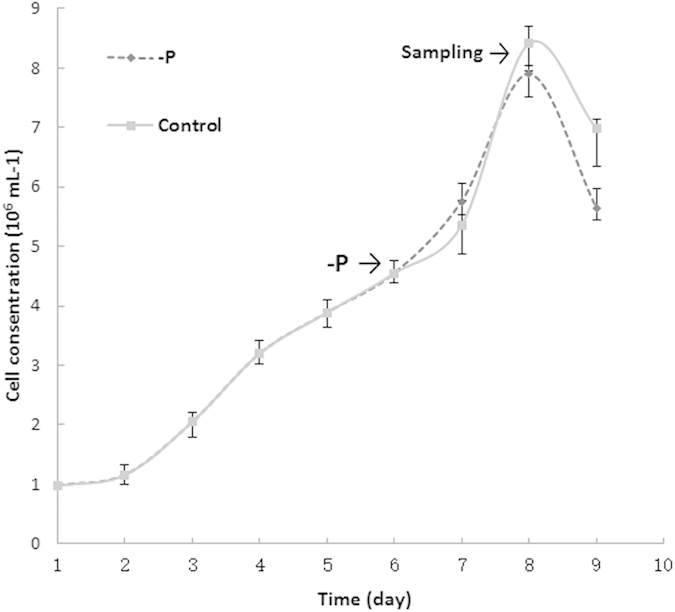
Time points of –P treatment and protein sampling.Six days after subculture P. tricornutum cells were treated with –P. Total protein was extracted from cultures at 48 h after –P treatment.